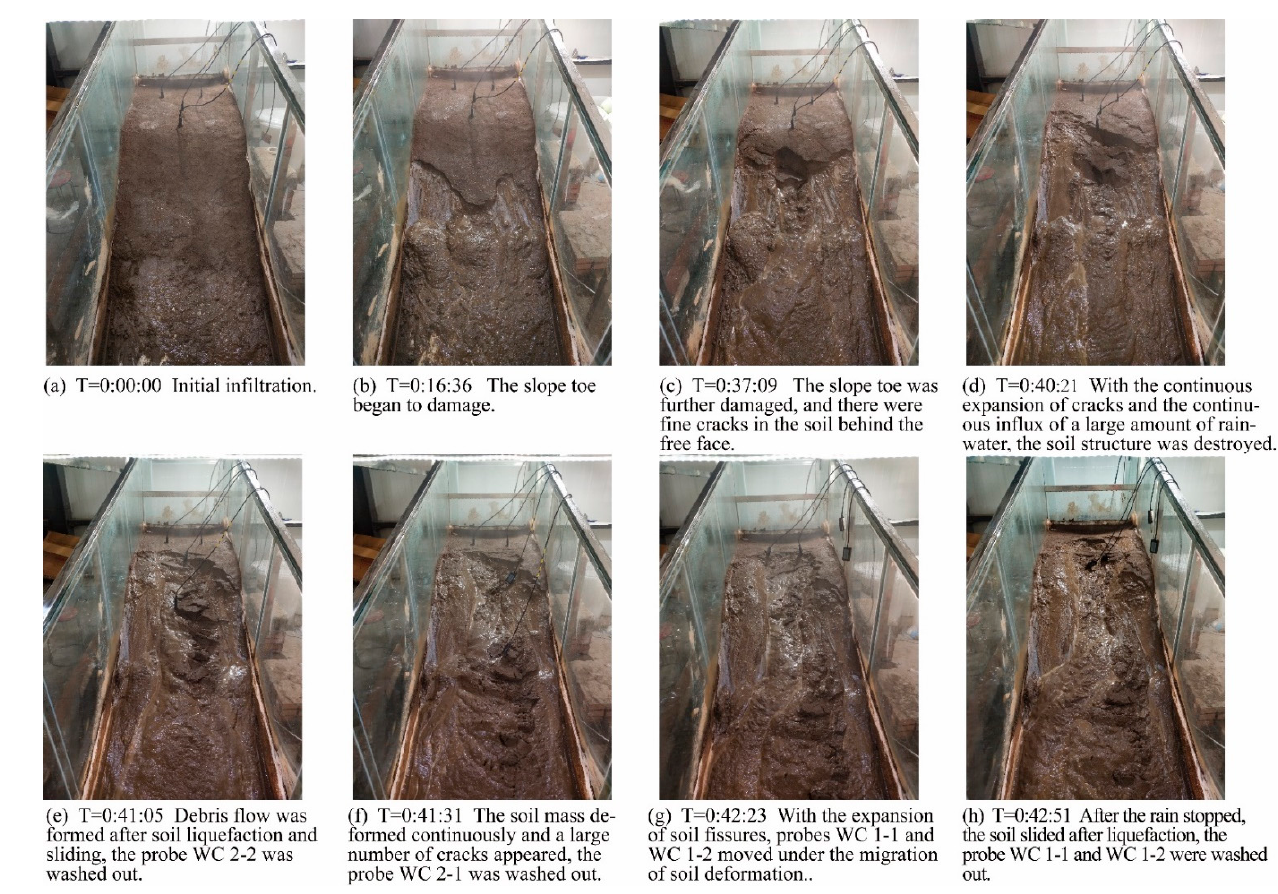
Figure 13. Damage characteristics of DMTG condition under extraordinary rainstorm (77.65 mm/h). Figure 12. Damage characteristics of DMTG condition under extraordinary rainstorm (77.65